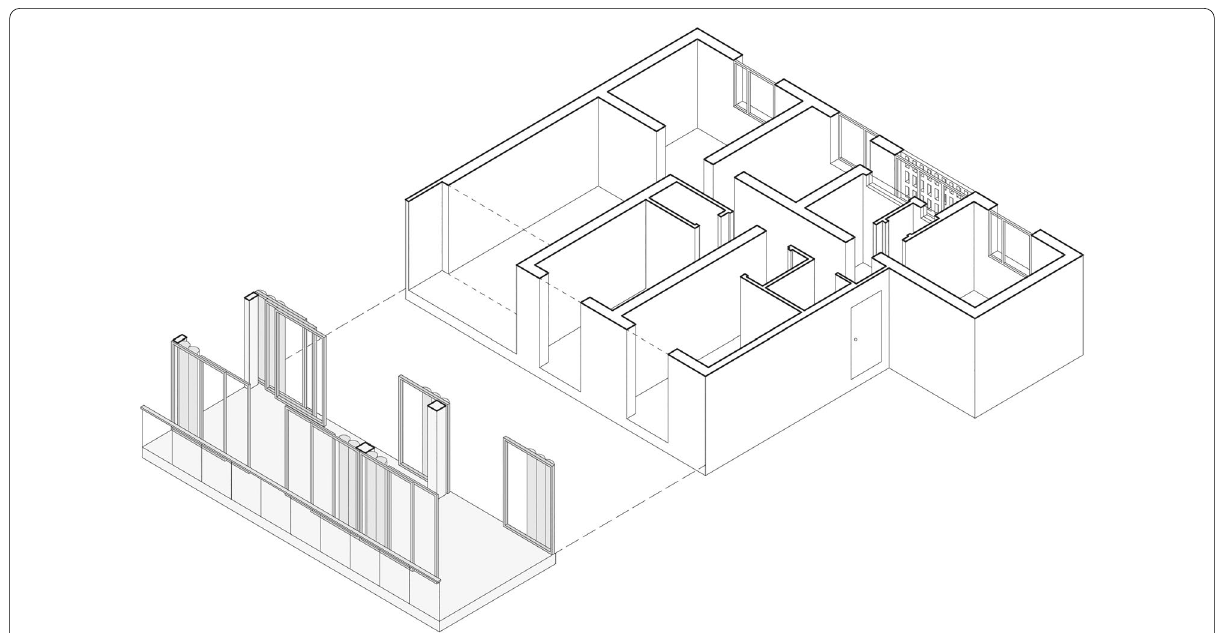
Fig. 5 Housing Unit in the Grand Parc , Lacaton & Vassal, Bordeaux, 2017. Light gray: liminal space close to the